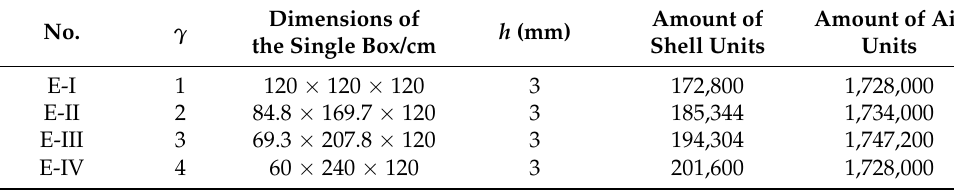
Table 6. Characteristic dimensions of multi-box structures.